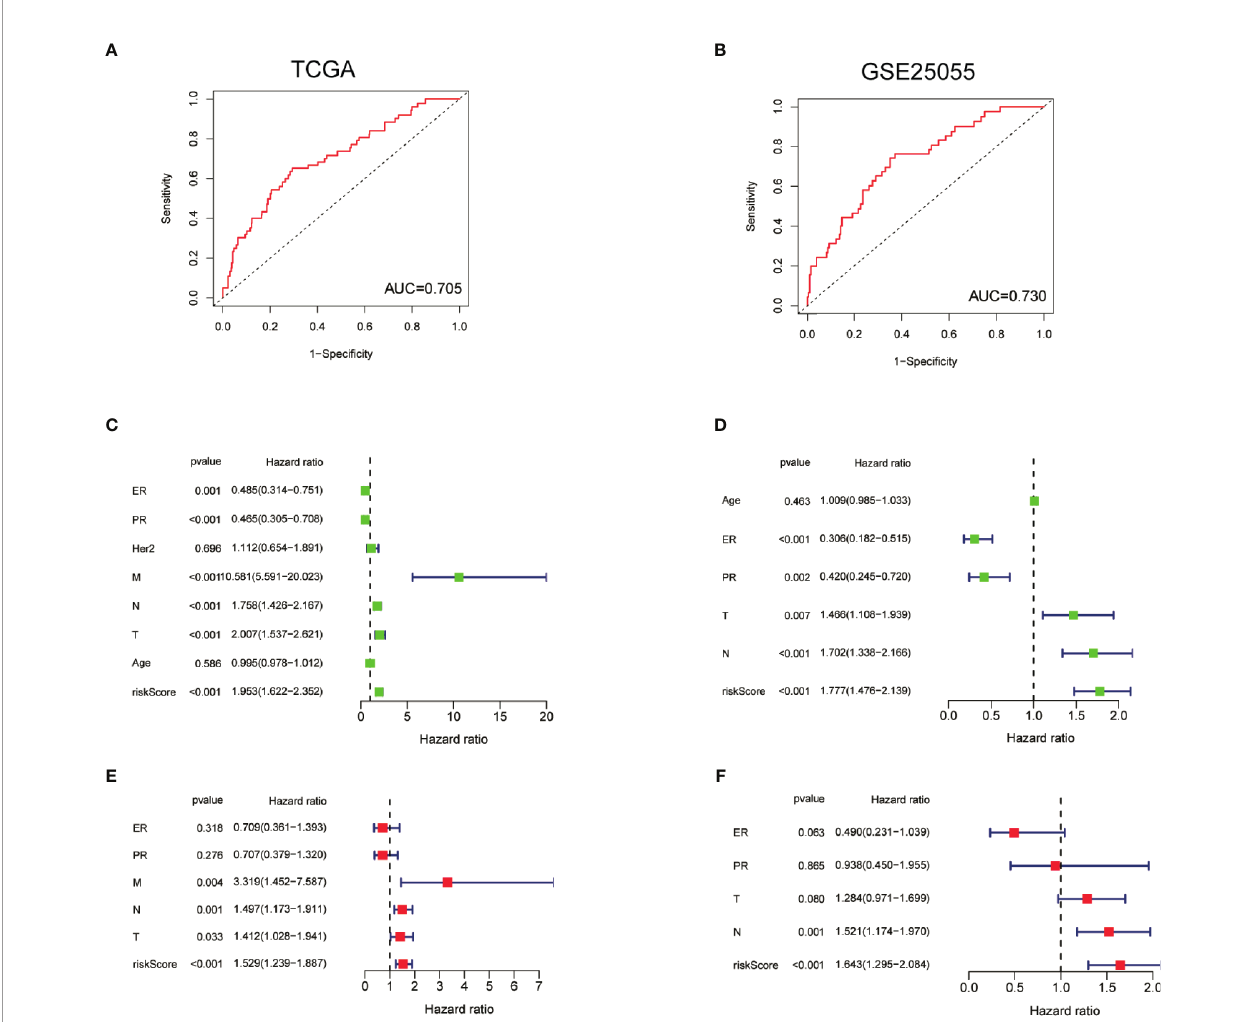
FIGURE 5 | ROC and strati fi cation analyses of the TF-related signature for PFI. (A, B) ROC curve indicating the predictive accuracy of the TF-related signature for PFI using TCGA and GSE25055 data. (C, D) Univariate Cox regression analysis of correlations between the risk score for PFI and clinical variables using TCGA data and GSE25055 data. (E, F) Multivariate Cox regression analysis of correlations between the risk score for PFI and clinical variables using TCGA and GSE25055